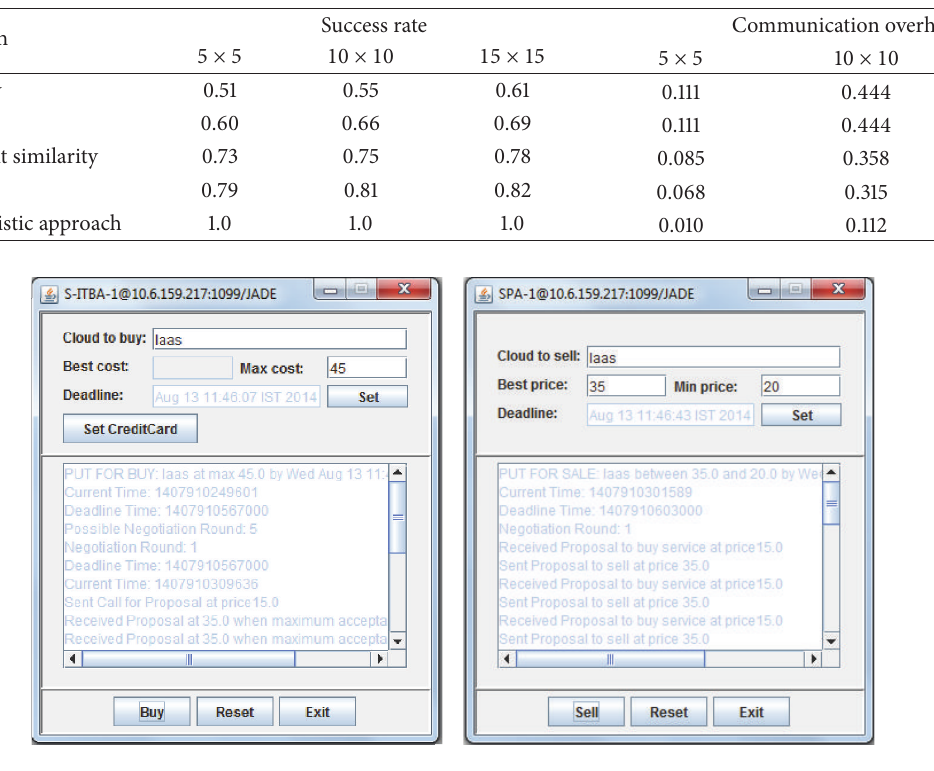
Figure 3: Preferences of broker and provider agent.